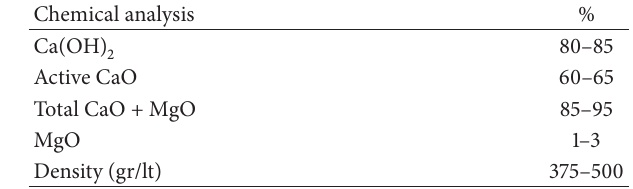
Table 2: Liquid limit and plastic limit experiments for natural soil and lime state.